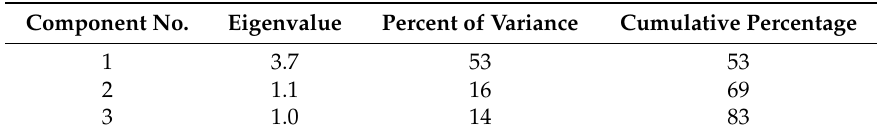
Table 2. Eigenvalues and explained variance by three components on the environmental data (PCA). Component No.